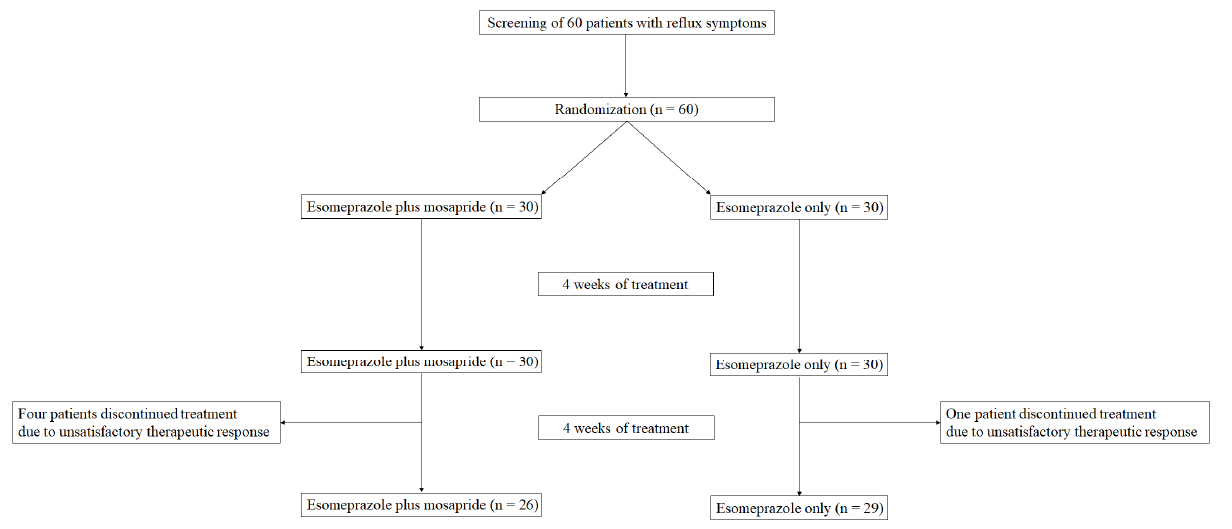
Figure 1. Flow chart of the patients included in the